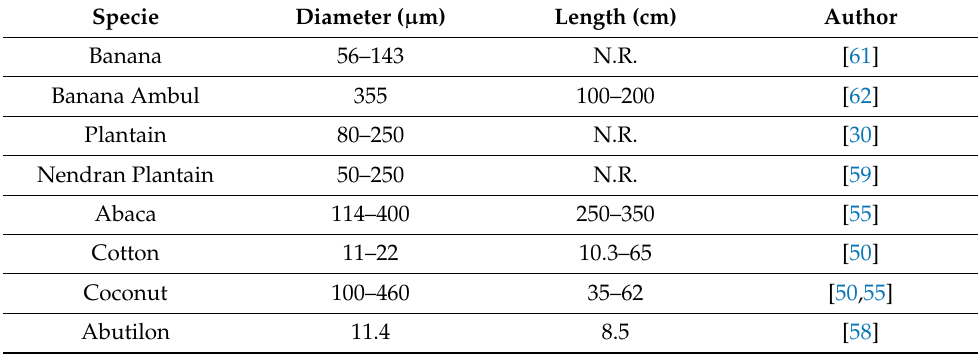
Table 3. Physical properties of different sources of lignocellulosic